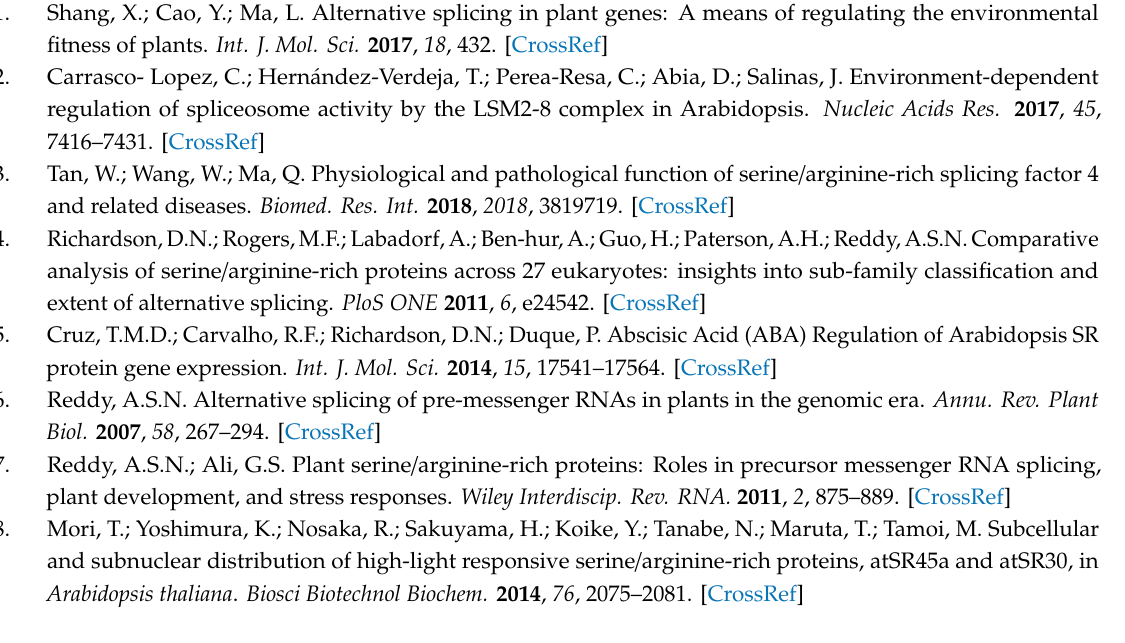
Figure S1: BrSR45a promoter sequences with marked region of potential promoter motifs, Figure S2: PCR based genotyping for selection of homozygous SR45a mutants from SALK_052345 seedlings, Figure S3: Chlorophyll a fluorescence transients (OJIP curves) in dark adopted leaves of Arabidopsis seedlings BrSR45a overexpressors, Col-0, mutant-6 and mutant-8 subjected to drought stress (15 DAS), Figure S4: BrSR45a interaction with other proteins predicted by string-db online tools, Figure S5: Expression of stress markers under di ff erent time interval (0, 3rd, 5th, and 8th days) of progressive drought stress, Figure S6: BrSR45a expression pattern in selected transgenic lines (OE-2, OE-1), mutants ( SR45a knock-out) and Col-0, Figure S7: The expression pattern of antioxidative enzyme genes in selected transgenic lines (OE-2, OE-1) and control (Col-0), Figure S8: Measurement of Superoxide dismutase (SOD) enzyme activity during di ff erent times of drought stress (d-0, 5, 7) in in selected transgenic lines (OE-2, OE-1), and control (Col-0) Arabidopsis plants, Table S1: List of primers and their annealing temperature used in this